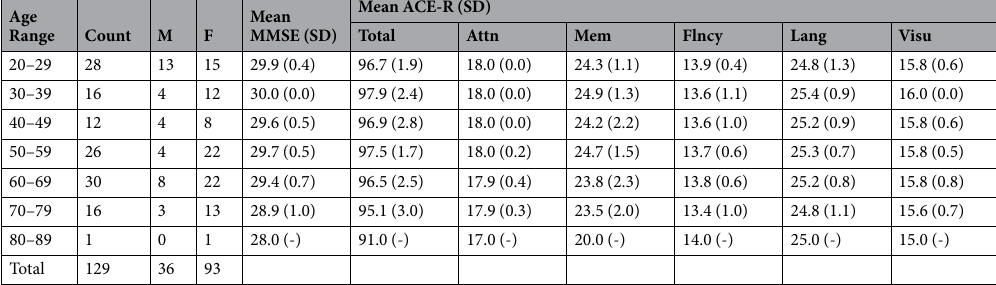
will be reported elsewhere.